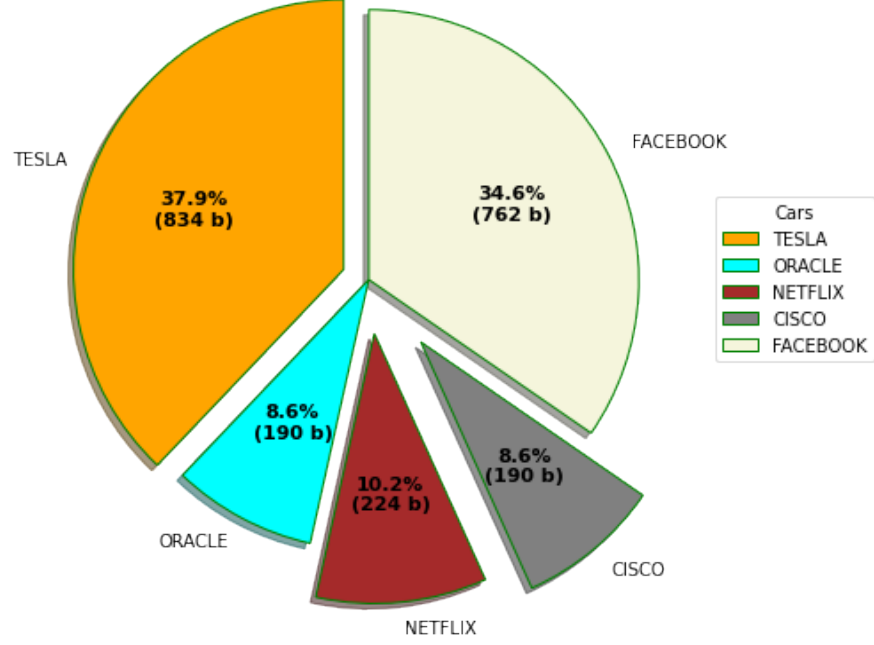
Figure 2. Tech companies with billion-dollar